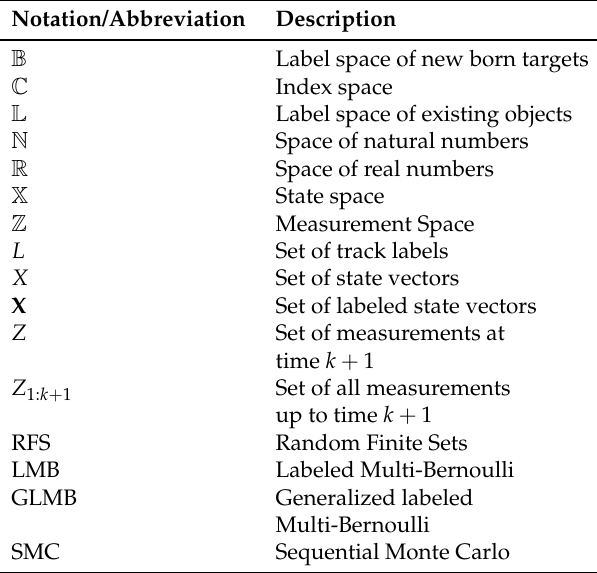
Table 1. Notations and abbreviations used in this